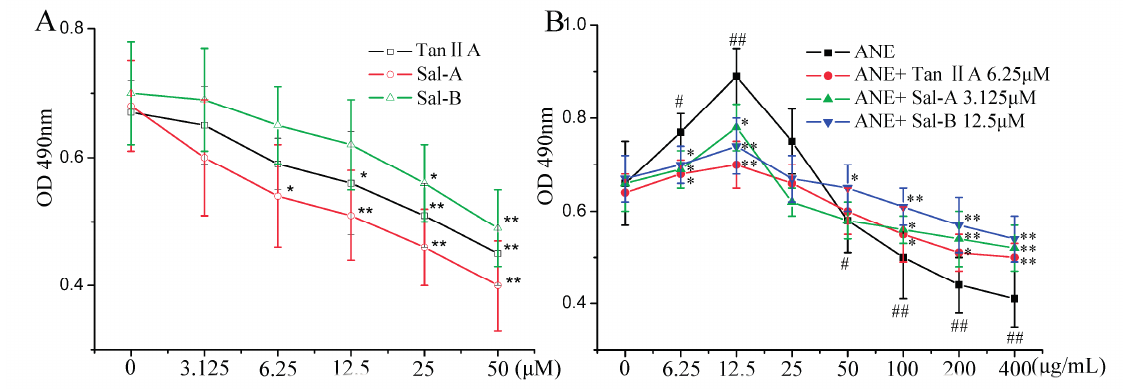
Figure 1. Tanshinone IIA (Tan-IIA), salvianolic acid A (Sal-A) and Sal-B ameliorated the areca nut extract (ANE)-induced abnormal viability of mice oral mucosal fibroblasts (MOMFs). ( A ) The cytotoxicity of Tan-IIA, Sal-A and Sal-B on MOMFs. After being exposed to Tan-IIA, Sal-A and Sal-B for 48 h, the cell viability was measured by the MTT method; n = 5, * p < 0.05 and ** p < 0.01 vs. the 0 μ M group. ( B ) The influence of Tan-IIA, Sal-A and Sal-B on the ANE-induced abnormal viability of MOMFs. After being exposed to ANE (12.5 μ g/mL) with or without Tan-IIA (6.25 μ M), Sal-A (3.125 μ M) and Sal-B (12.5 μ M) for 48 h, the cell viability was measured by the MTT method. Data are expressed as the means ± SD. n = 5. # p < 0.05 and ## p < 0.01 vs. the 0 μ g/mL ANE